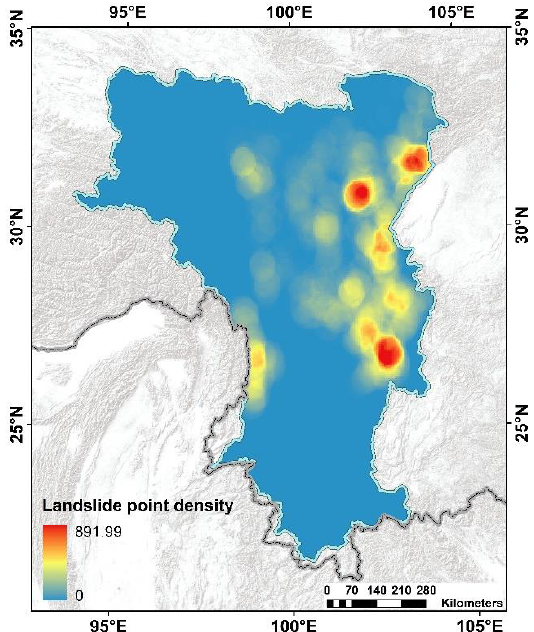
Figure A2. Point density map of training landslide data.